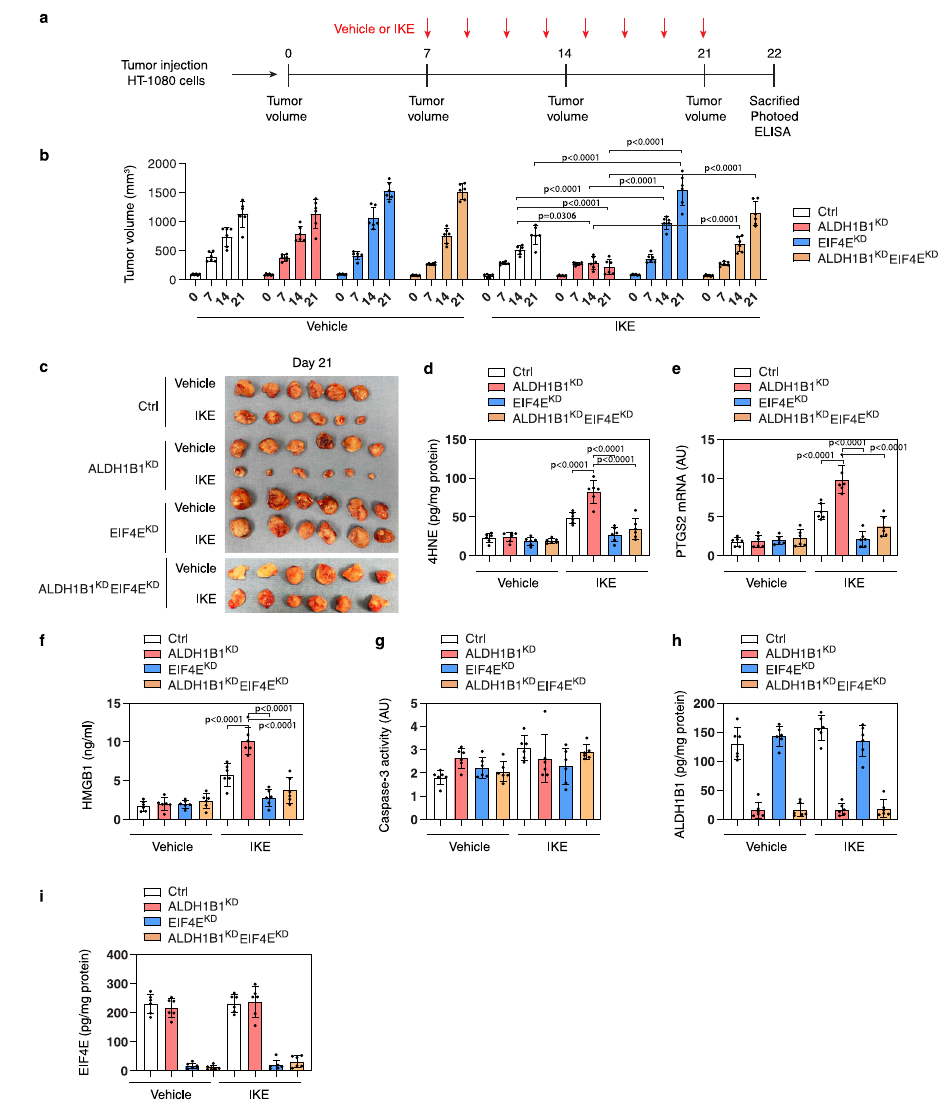
Fig. 5 | EIF4E and ALDH1B1 regulates ferroptosissensitivityin vivo.a A scheme of treatment in an HT-1080 xenograft tumor model with IKE. Athymic nude mice were injected subcutaneously with indicated ALDH1B1-knockdown (ALDH1B1 KD ) or EIF4E-knockdown (EIF4E KD ) HT-1080 cells for 7 days and then treated with IKE (40mg/kg, i.p., once every other day) at day 7 for 2 weeks. b Tumor volumes were calculated weekly ( n =6 mice/group; two-way ANOVA with Tukey ’ s